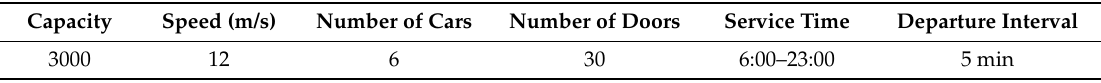
Table 2. The values of metro attributes in reality.